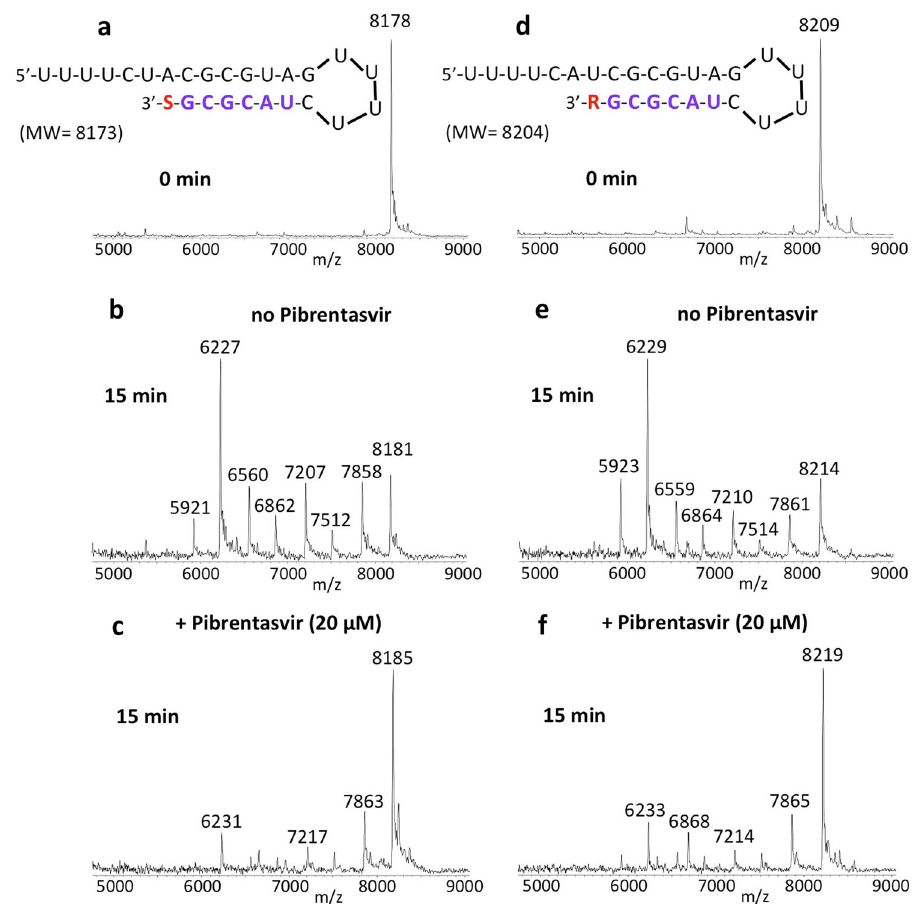
Fig. 4 Inhibition of SARS-CoV-2 exonuclease activity by Pibrentasvir for Sofosbuvir (S) and Remdesivir (R) terminated RNA. A mixture of 500 nM RNAs (sequences shown at the top of the fi gure) and 50 nM SARS-CoV-2 pre-assembled exonuclease complex (nsp14/nsp10) were incubated in buffer solution at 37 °C for 15 min in the absence ( b , e ) and presence of 20 µ M Pibrentasvir ( c , f ). The intact RNAs ( a , d ) and the products of the exonuclease reactions ( b – f ) were analyzed by MALDI-TOF MS. The signal intensity was normalized to the highest peak. In the absence of Pibrentasvir, exonuclease activity caused nucleotide cleavage from the 3 ′ -end of the RNA as shown by the lower molecular weight fragments corresponding to cleavage of 1 – 7 nucleotides ( b , e ). When 20 µ M Pibrentasvir was added, exonuclease activity was reduced as shown by the reduced intensities of the fragmentation peaks and increased intact RNA peaks ( c , f